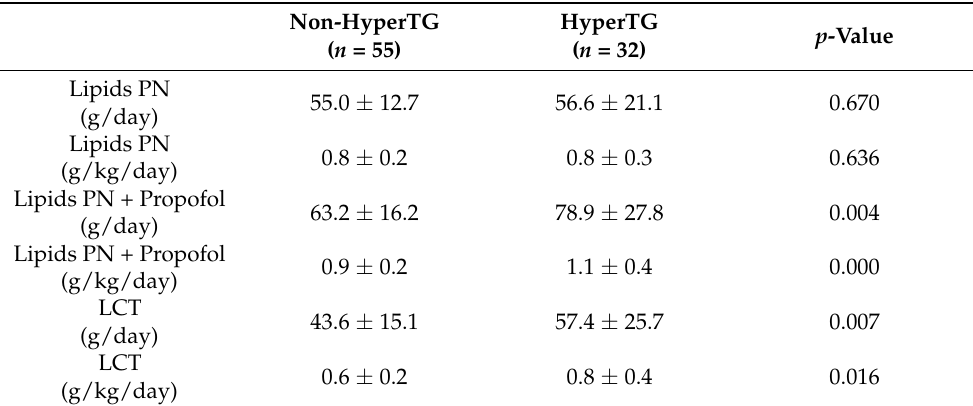
Table 3. Lipid dose from PN and Propofol as well as total lipid dose from long-chain TG the day before the diagnosis of hypertriglyceridemia.